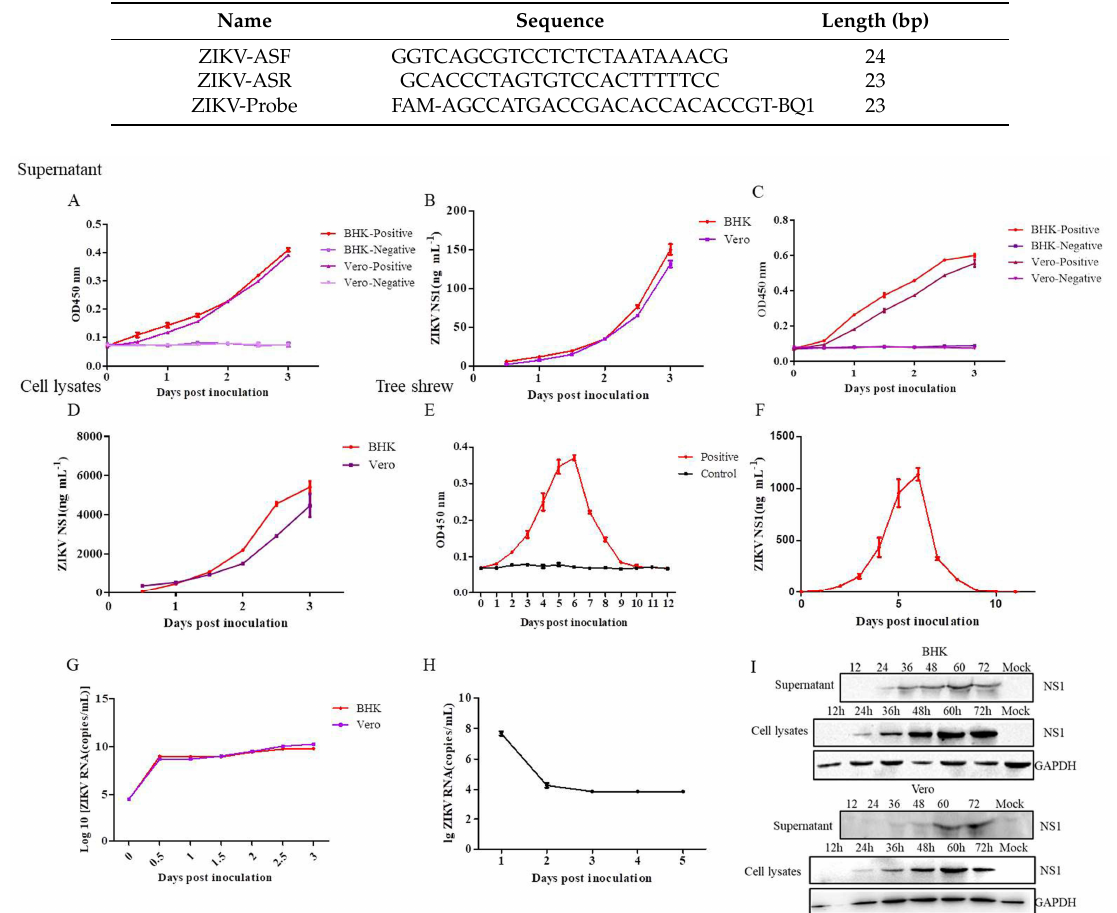
Figure 6. Detection of the ZIKV-NS1 protein in cell culture supernatants and lyates, as well as sera of animal infection model by the DAS-ELISA. Supernatants ( A , B ) and cell lysates ( C , D ) of Vero and BHK cells infected with ZIKV from 12, 24, 36, 48, 60, and 72 h were detected by DAS-ELISA. ( E , F ) Sera of tree shrews infected with ZIKV from 1 to 12 days were detected by DAS-ELISA. A Real-time quantitative reverse transcription polymerase chain reaction analysis of the supernatant of Vero, BHK ( G ) and the sera of tree shrews ( H ) after infected with ZIKV. ( I ) Western blot assay of supernatants and cell lysates of BHK and Vero cells infected with